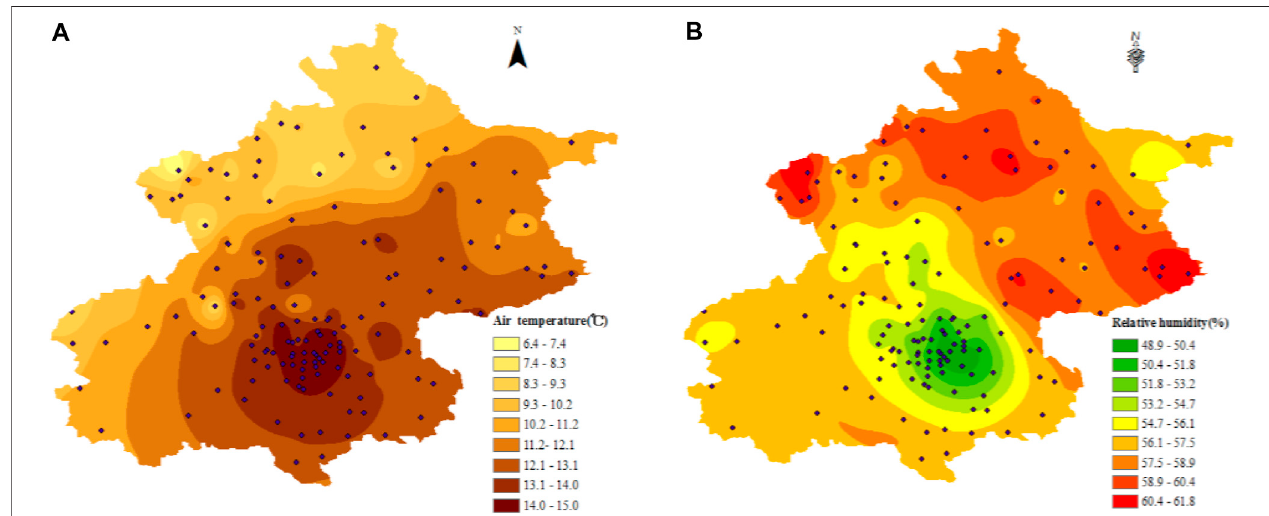
FIGURE 11 | Distribution maps of annual averaged (A) air temperature and (B) relative humidity in Beijing. 143 Black dots represent the automatic weather